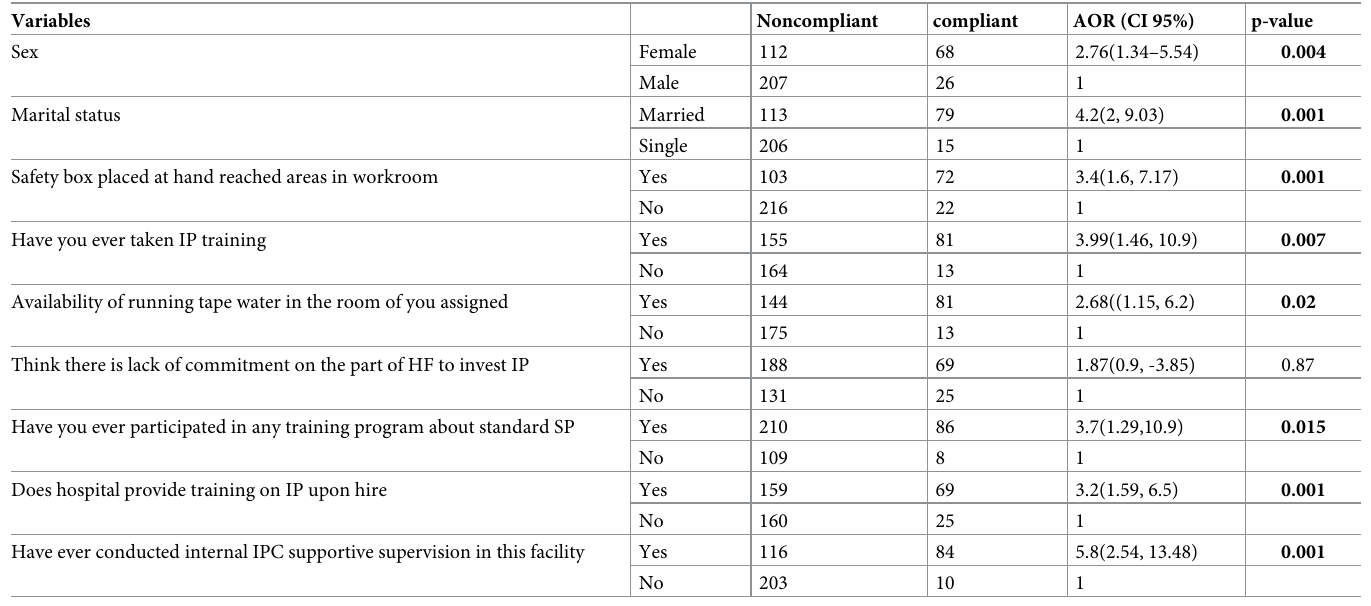
Table 4. Multivariable analysis result for factors affecting compliance with standard safety precautions in Hawassa comprehensive specialized hospital,